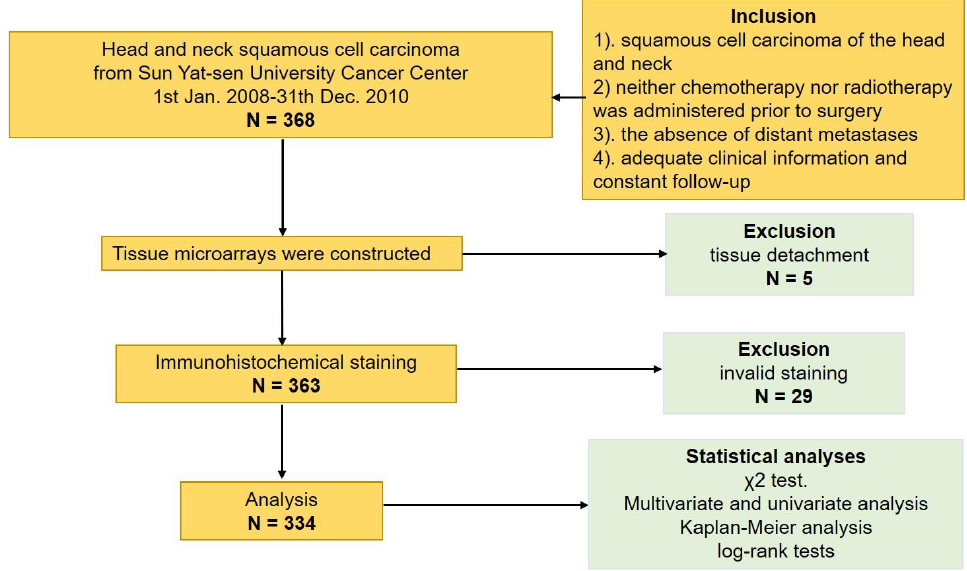
Figure 1. The flow diagram of this study. Table 1. Associations between FOXD1 expression level and clinicopathological characteristics of HNSCC patients.